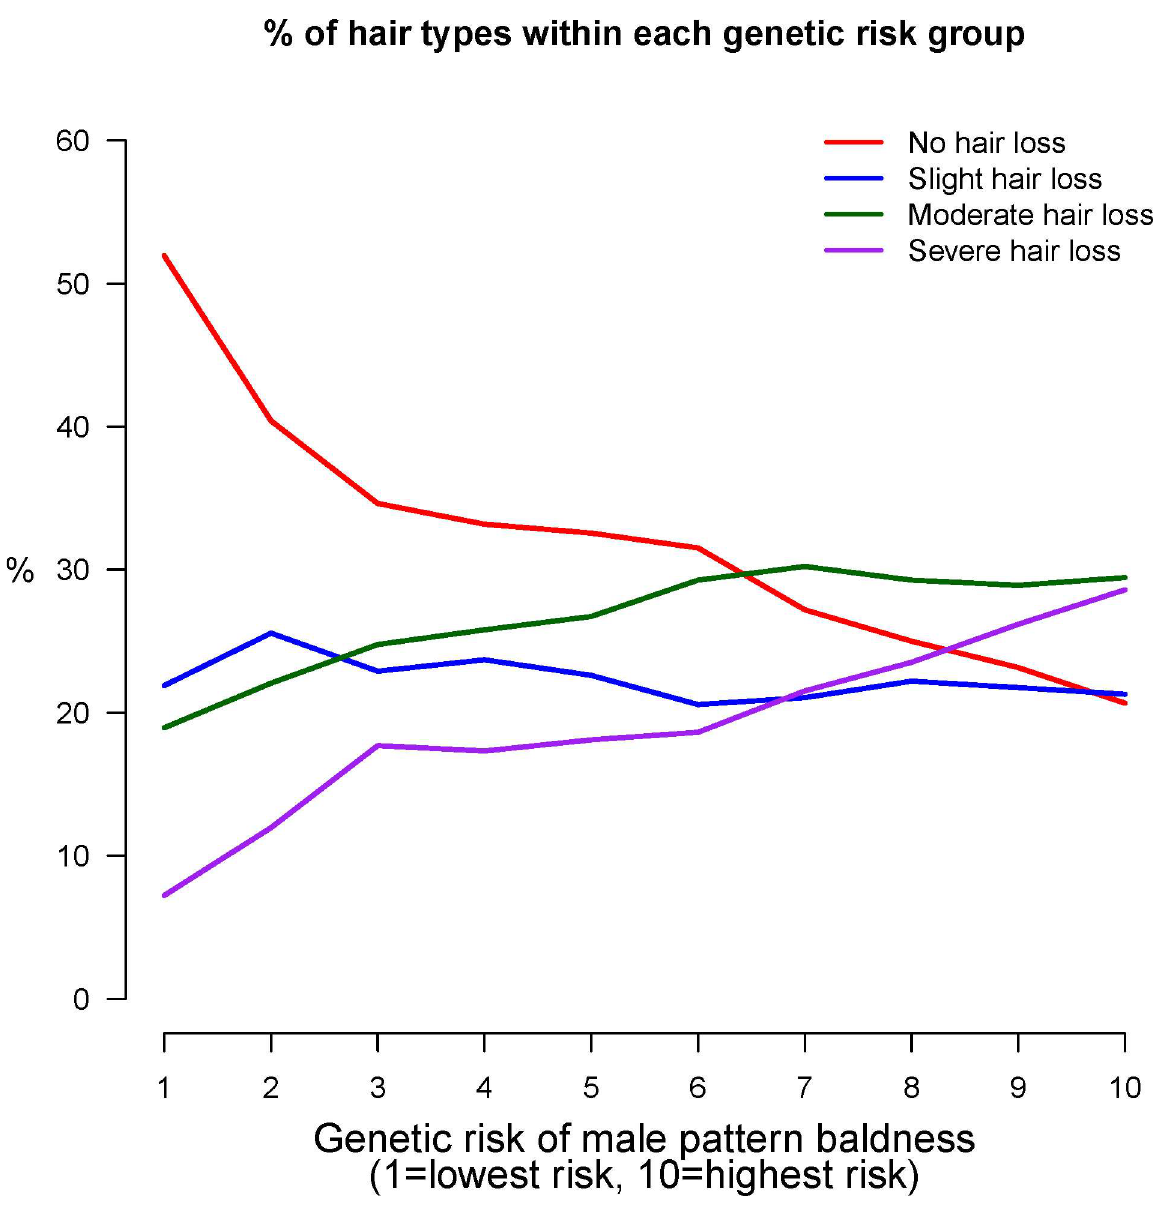
Fig 3. Distribution of hair loss by male pattern baldness polygenic score decile in the independent sample.